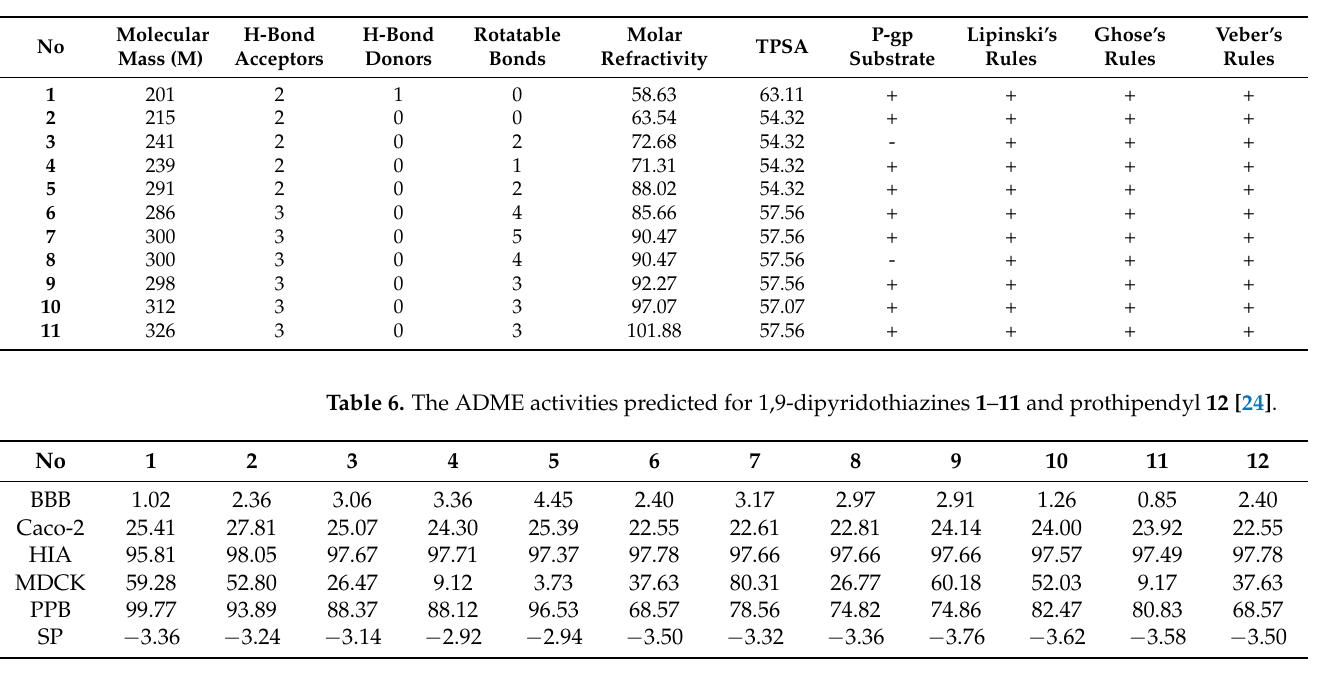
Table 5. The molecular descriptor and parameters of Lipinski’s, Ghose’s, and Veber’s rules for